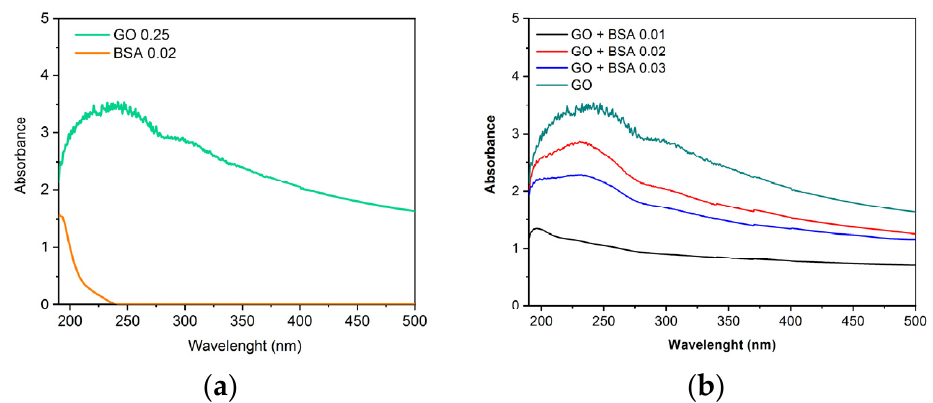
Figure 3. Absorbance vs. wavelength. ( a ) Spectra of GO (0.25 mg/mL) and BSA (0.02 mg/mL). ( b ) Spectra of GO (0.25 mg/mL) with different concentrations of BSA obtained by UV-Vis spectropho- tometer.